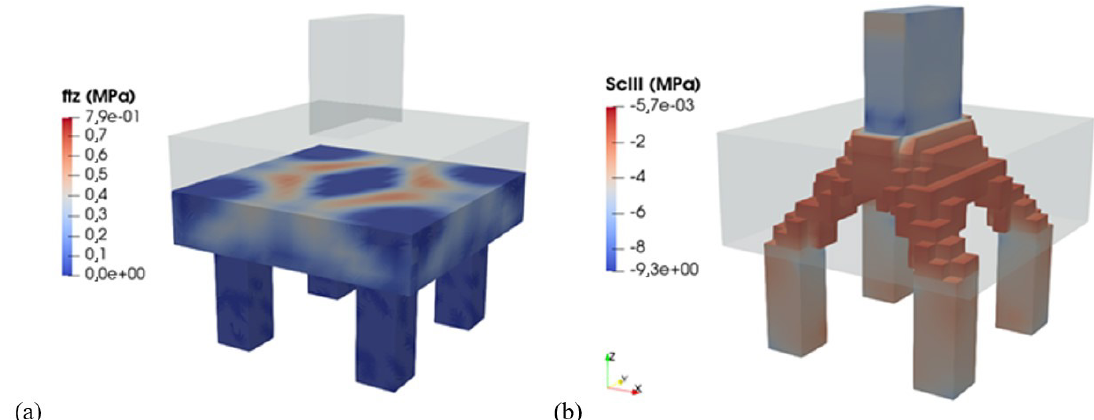
Figure 14. Four-pile cap: (a) reinforcement equivalent stress f tz ; (b) elements with concrete principal stress σ III lower than -1,0 MPa